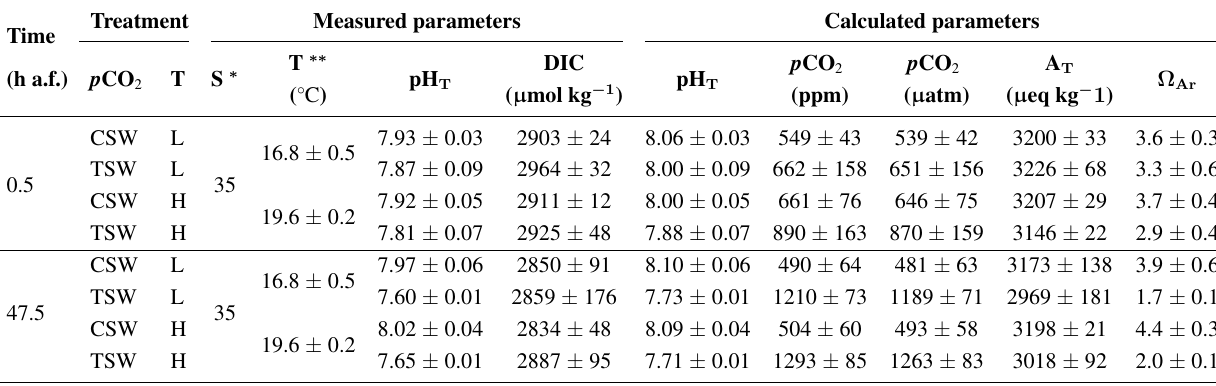
Table 1. Mean ( ± 1 σ , n = 3) pH, carbon chemistry and calcite saturation state parameters of experimental seawater for p CO control (CSW, 380 ppm), treatment (TSW, 1000 ppm), 2 temperature control (L, low) and treatment (H, high) cylinders 0.5 h after fertilization [(a.f., 2 h before addition of embryos (a.e.)] and 47.5 a.f. (44.5 h a.e.). S refers to salinity; T to temperature, pH to pH in total scale; DIC to dissolved organic carbon; A to total alkalinity; T T and Ω to aragonite saturation state. Measured parameters were obtained at 25 ◦ C and Ar calculated for experimental temperatures using